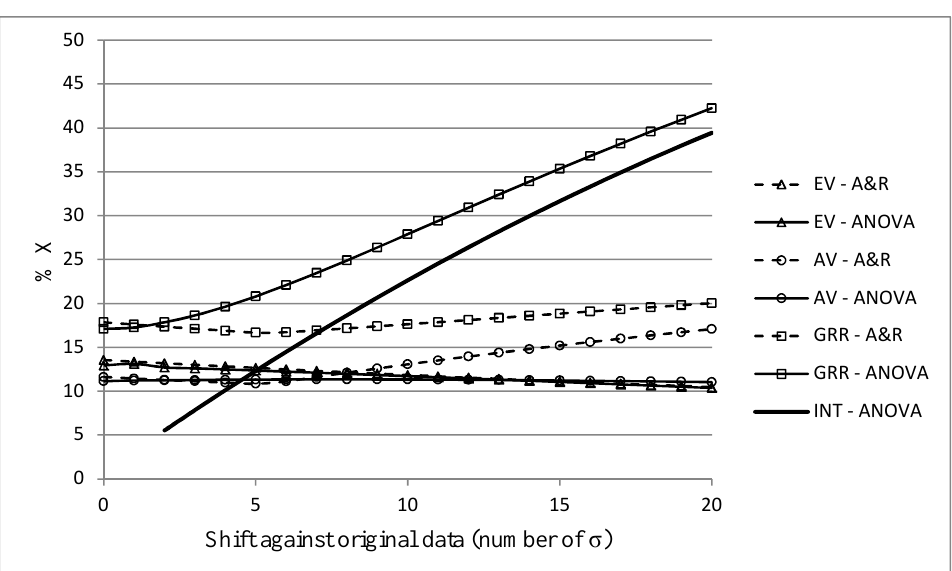
Figure 4 Changes in GRR study results for Simulation